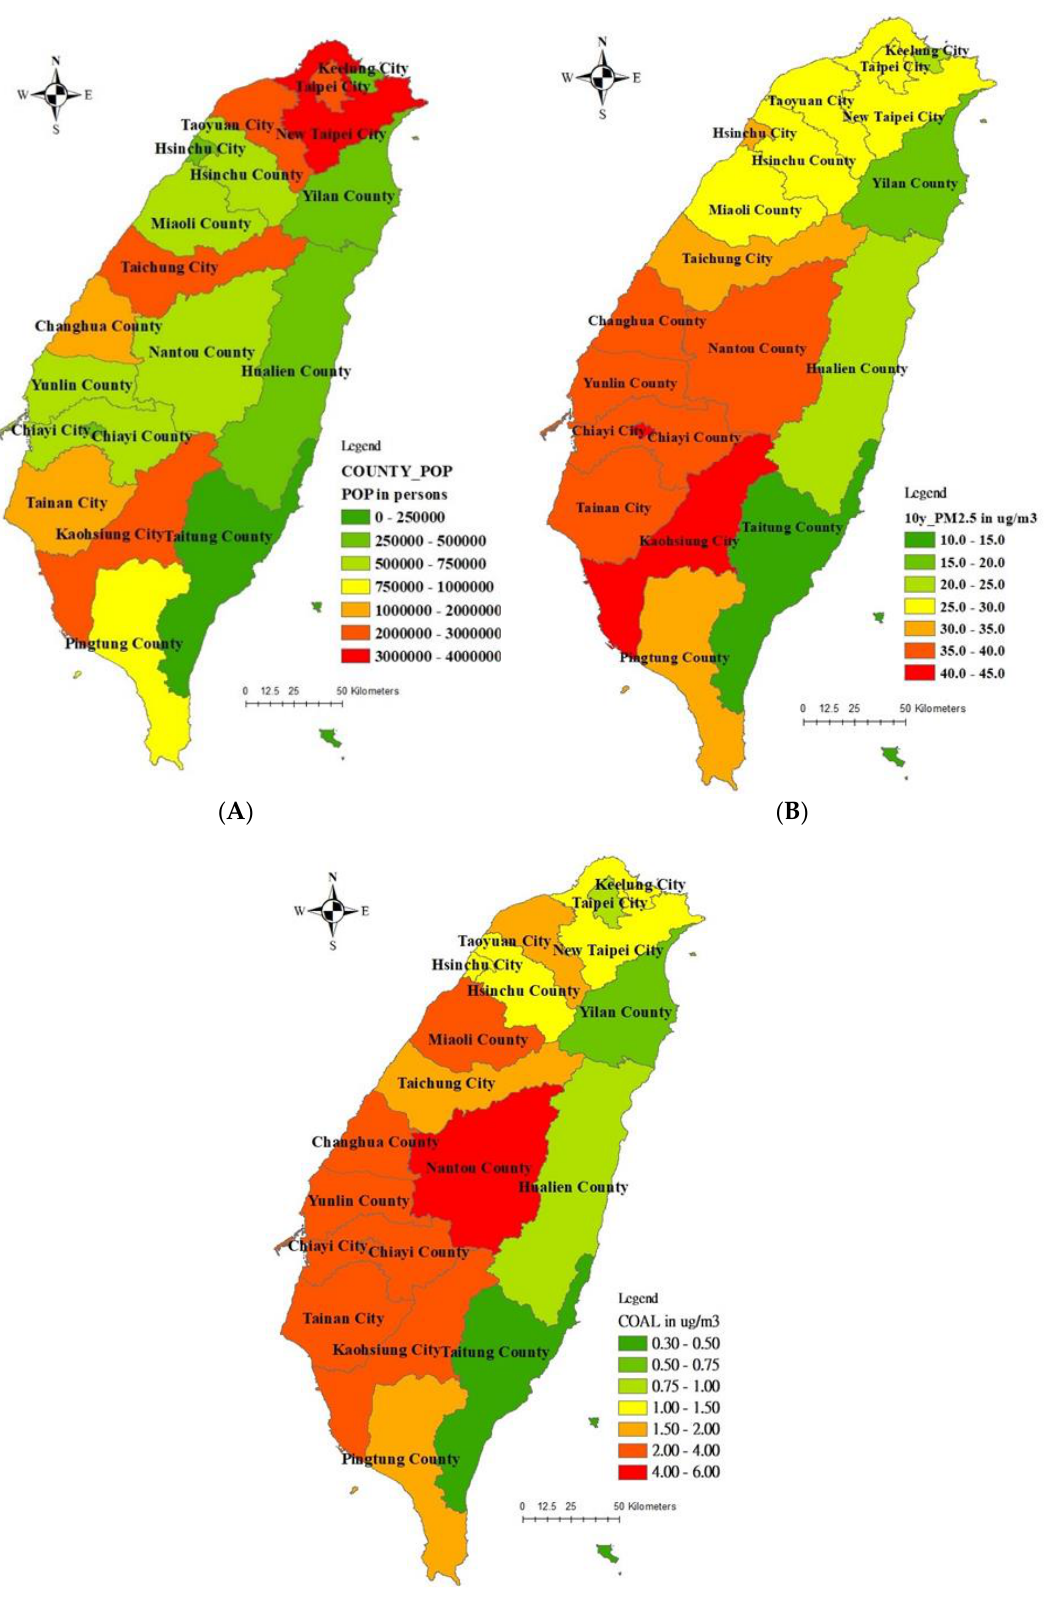
Figure 3. Spatial distribution of city/county based ( A ) populations, ( B ) 10-year averaged PM 2.5 concentration, and ( C ) GTx-modeled PM 2.5 estimates from all coal-fired power plants.